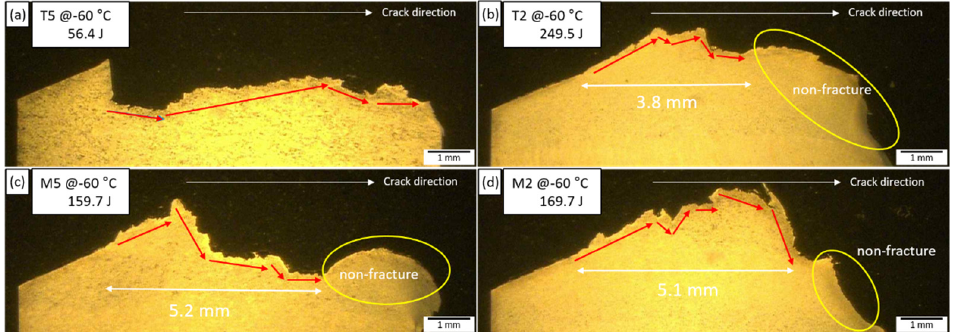
Figure 9. Optical micrographs of the cross-sectional areas of fracture surfaces of the Charpy impact test specimens fractured at − 60 °C: ( a ) 5 mm from F.L., ( b ) 2 mm from F.L. of top; ( c ) 5 mm from F.L., ( d ) 2 mm from F.L. of middle.